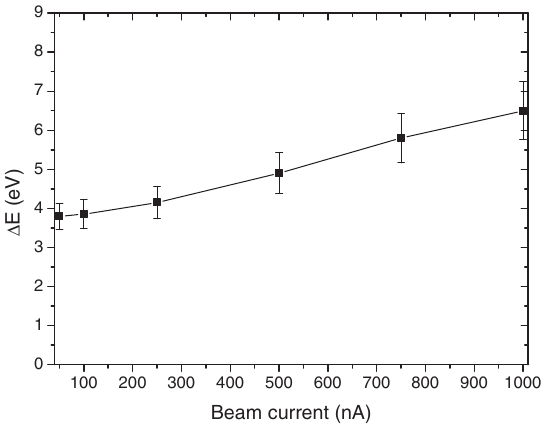
FIG. 4. Confinement effect of rf voltage amplitude on the longitudinal energy spread: variation of longitudinal energy spread Δ E with the Mathieu parameter q (i.e. rf voltage amplitude)